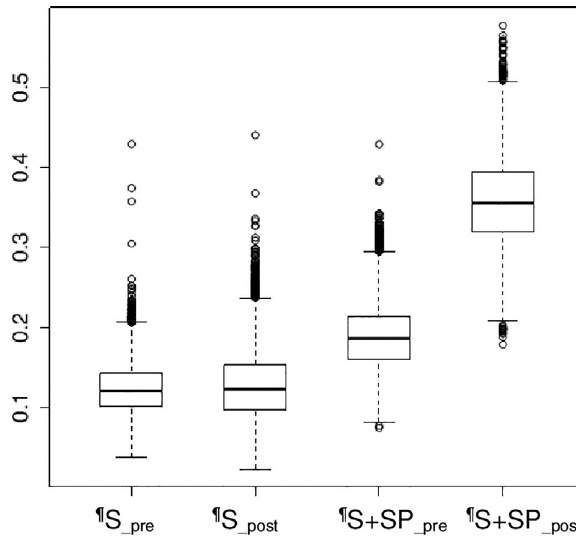
Figure 3 - Box plot of the posterior probability of volleyball perfect set in the Skill (S) and Skill and strength/power (S+SP) groups in the pre- and post-training assessments 36 .